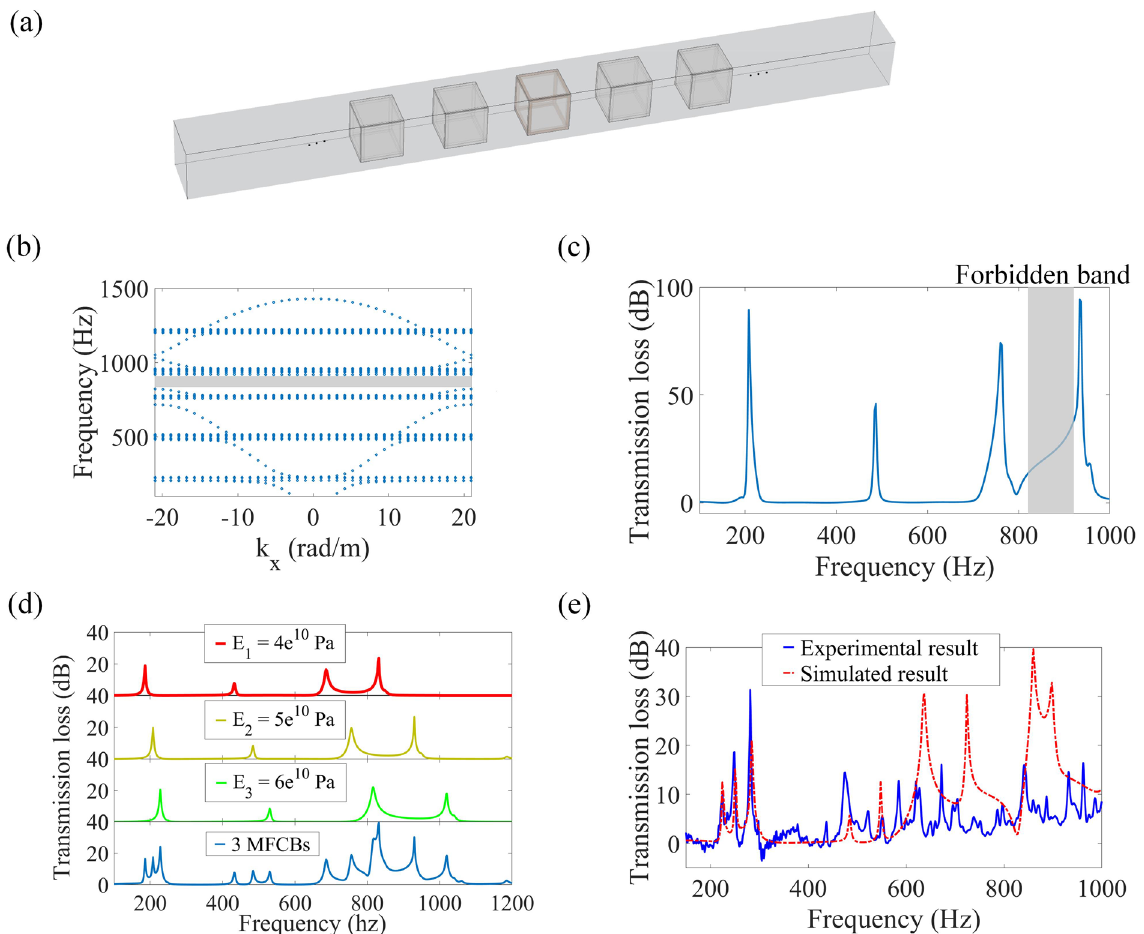
Figure 3. Performance of multiple MFCBs. ( a ) A string of MFCBs established in a pipe. ( b ) The dispersion of a periodic structure consisting of a string of MFCBs. The lattice constant is d = 15 cm and the equivalent Young’s modii of the MFCBs are identical, which are E = 4.9 × 10 string of five MFCBs with identical parameters. ( d ) Simulated transmission losses induced by three MFCBs with different Young’s moduli. ( e ) Comparing between simulated and measured transmission losses induced by three MFCBs with different Young’s modii of E 1 = 6.1 × 10 figure is created using MATLAB 2016 and COMSOL